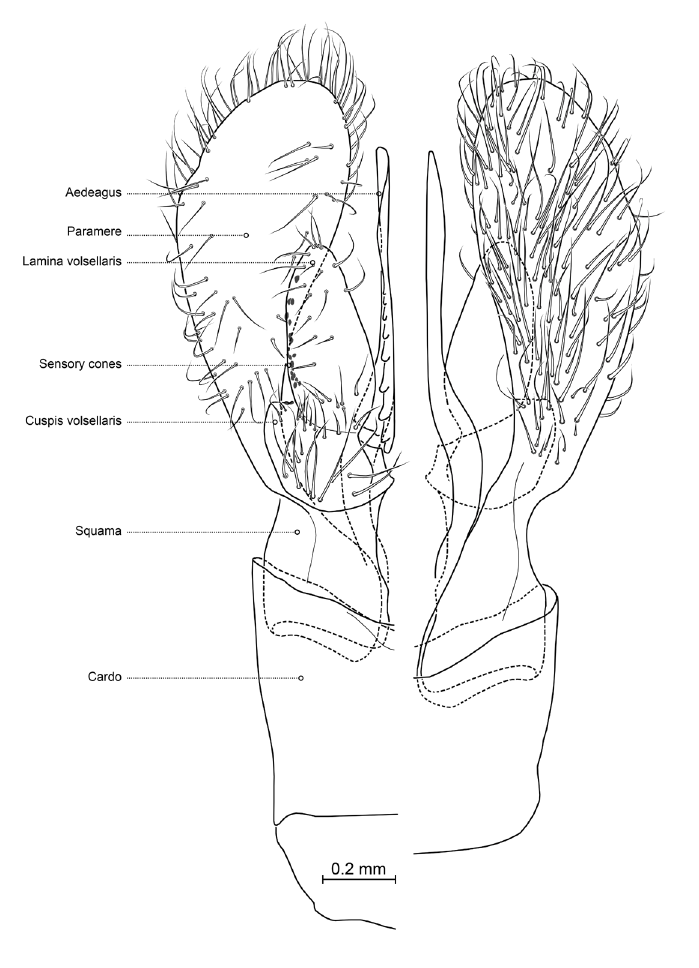
Fig. 6. Scolia pakshaoensis sp. nov., paratype, ♂ (CBC), genitalia. Ventral aspect at left, dorsal aspect at